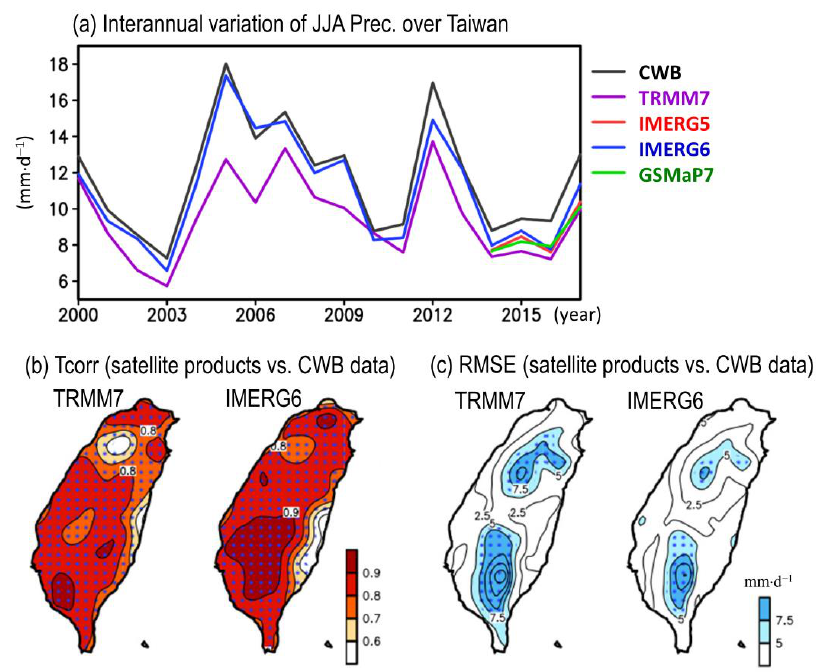
Figure 4. ( a ) Time series of the mean precipitation for the summers of 2000–2017, area-averaged over Taiwan, as estimated by the CWB data and SPPs. ( b ) and ( c ) is the related grid-to-grid Tcorr and RMSE, respectively, between the CWB data and the selected SPPs: TRMM7 and IMERG6. Here, the sample size for calculating Tcorr and RMSE is 18 JJAs. In ( b , c ), the values pass the 99% significant test are marked by